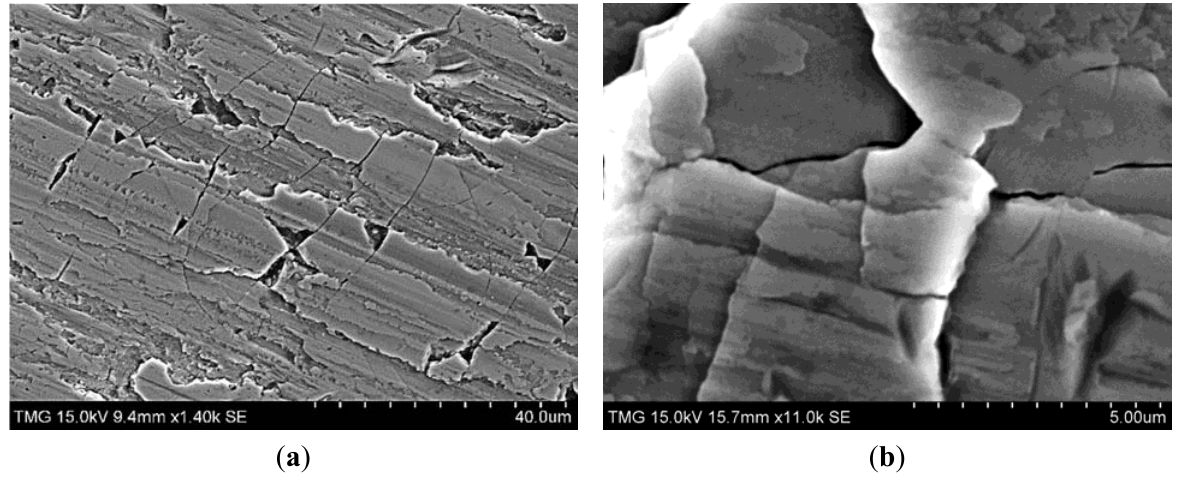
Figure 15. ( a ) and ( b ) Initiation of micro-cracks on the surface of the DR-treated Ti64 substrate due to the combined effect of water hammer pressure and compressive stress